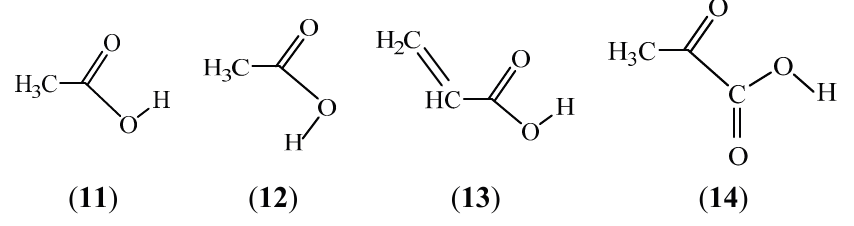
Figure 5. Structures of the syn ( 11 ) and anti ( 12 ) acetic acid, the s-cis propenic acid ( 13 ) and the s-trans pyruvic acid ( 14 ). The carboxylic group is syn for the latter